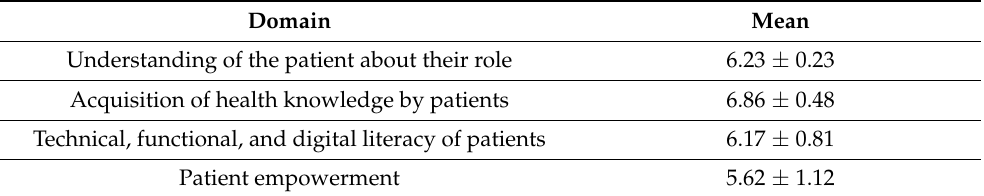
Table 8. Average results for the four main domain questions in the patient